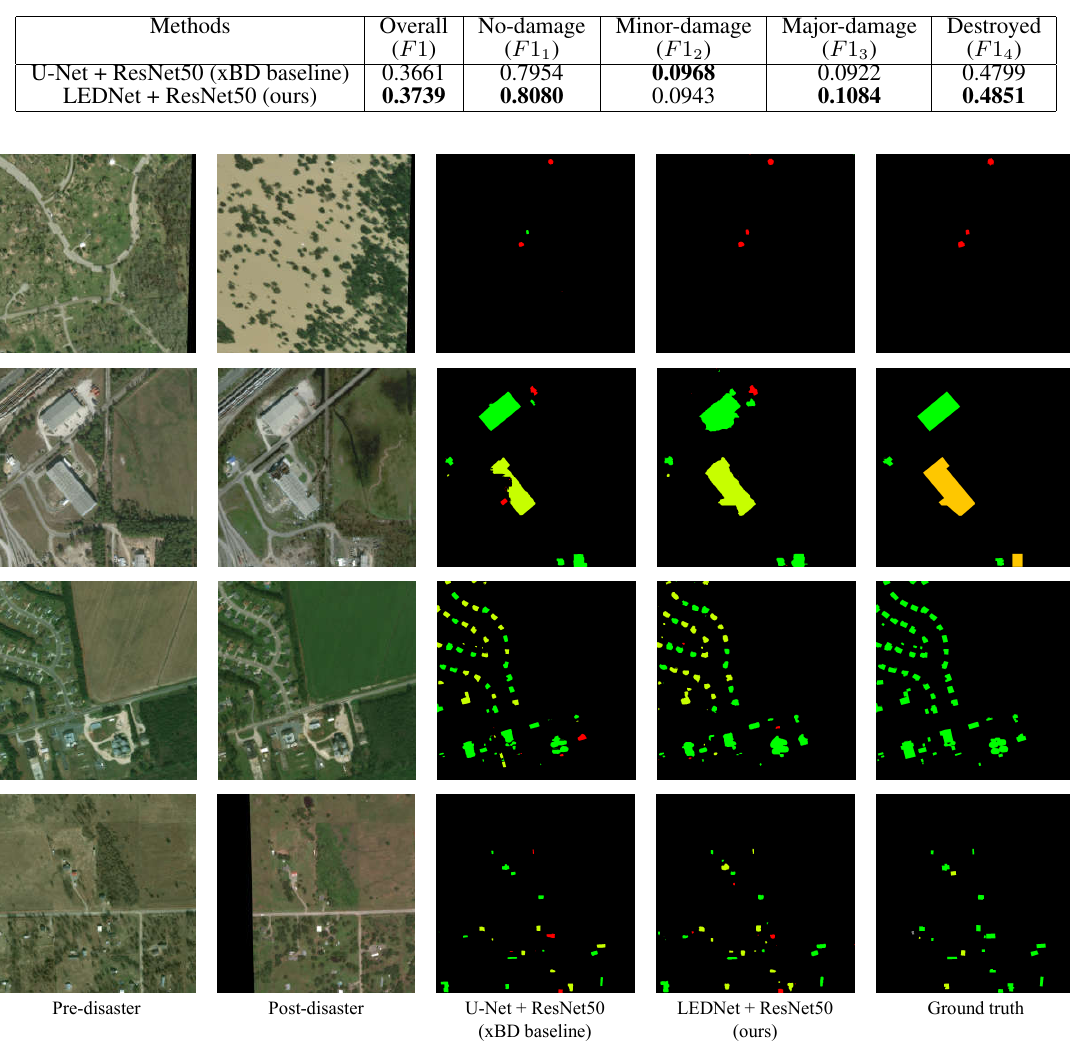
Figure 6. Qualitative evaluation for building damage